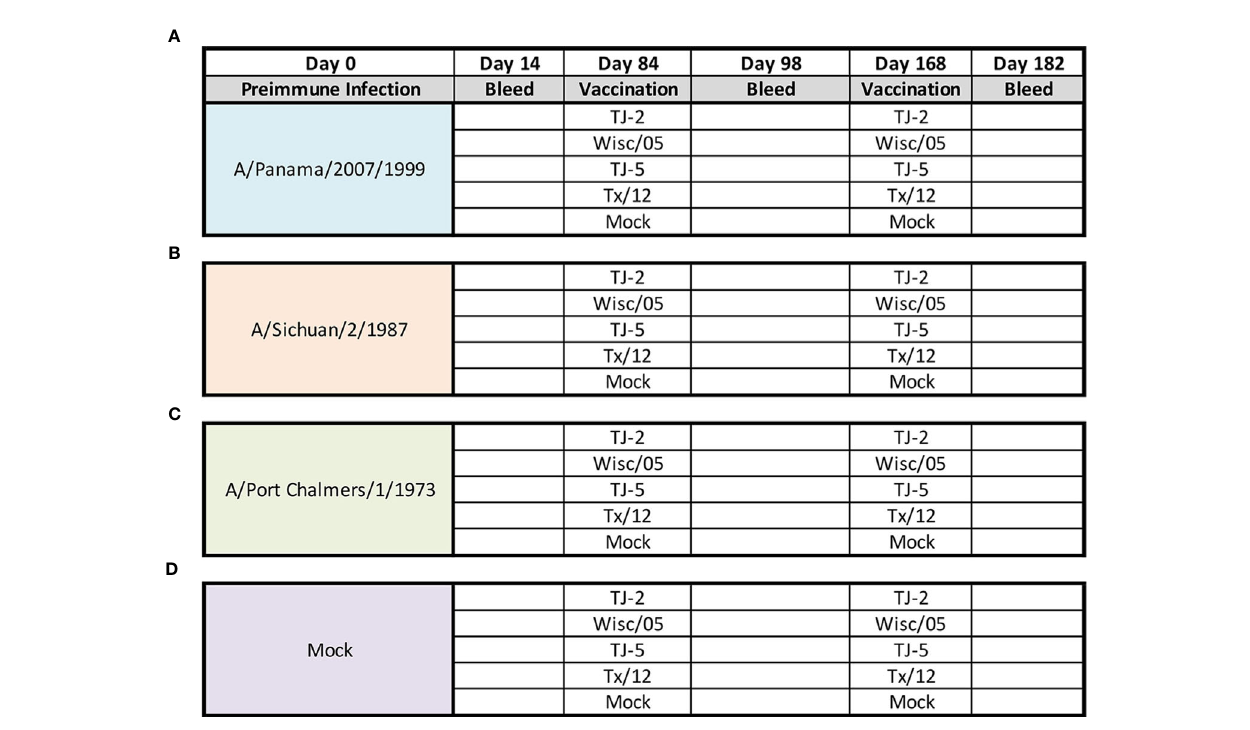
FIGURE 1 | Experimental Design. Eerrets were infected intranasally at day 0 with 1x106 PFU/mL of in fl uenza A(H3N2) virus: A/Panama/2007/1999 (A) , A/Sichuan/ 2/1987 (B) , A/Port Chalmers/1/1973 (C) , or 1mL of PBS (Mock) (D) . At 14 days post infection blood was collected from all animals. After 84 days animals were divided into groups (n=4 ferrets/group) and vaccinated intramuscularly with 15ug of either TJ-2, TJ-5, Tx/12, or Wisc/05 H3N3 VLP ’ s, or PBS (Mock) mixed 1:1 with adjuvant. At 98 days post infection blood was collected from all animals. At day 168 all animals were boosted with a homologous vaccine to that administered on day 84. A fi nal blood draw was collected at day 182 post infection.